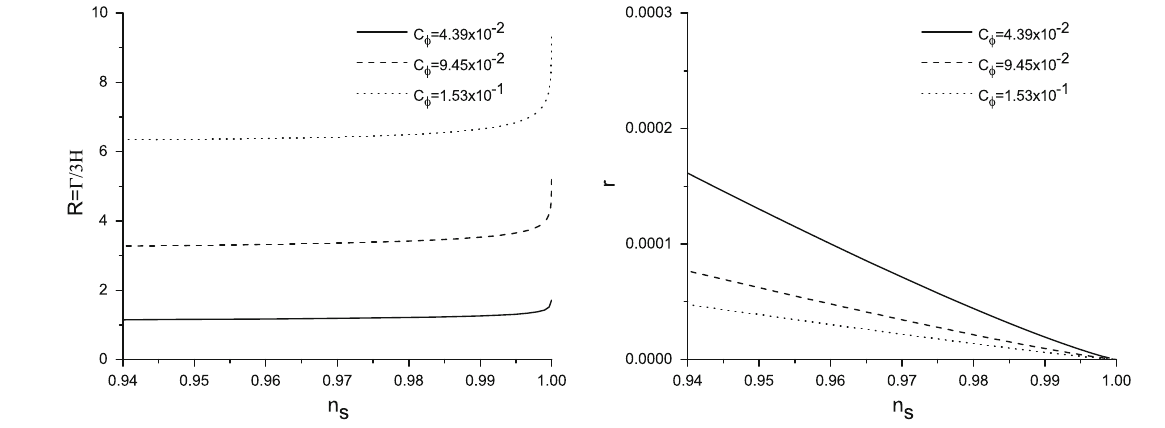
els , the dotted , dashed , and solid lines correspond to the pairs of values ( α = 0.25, V 0 = 1.03 × 10 − 12 ), ( α = 0.45, V 0 = 1.09 × 10 − 12 ), and ( α = 0.65, V 0 = 1.19 × 10 − 12 ), respectively. In these plots, we have fixed the values C γ = 70 and M p = 1